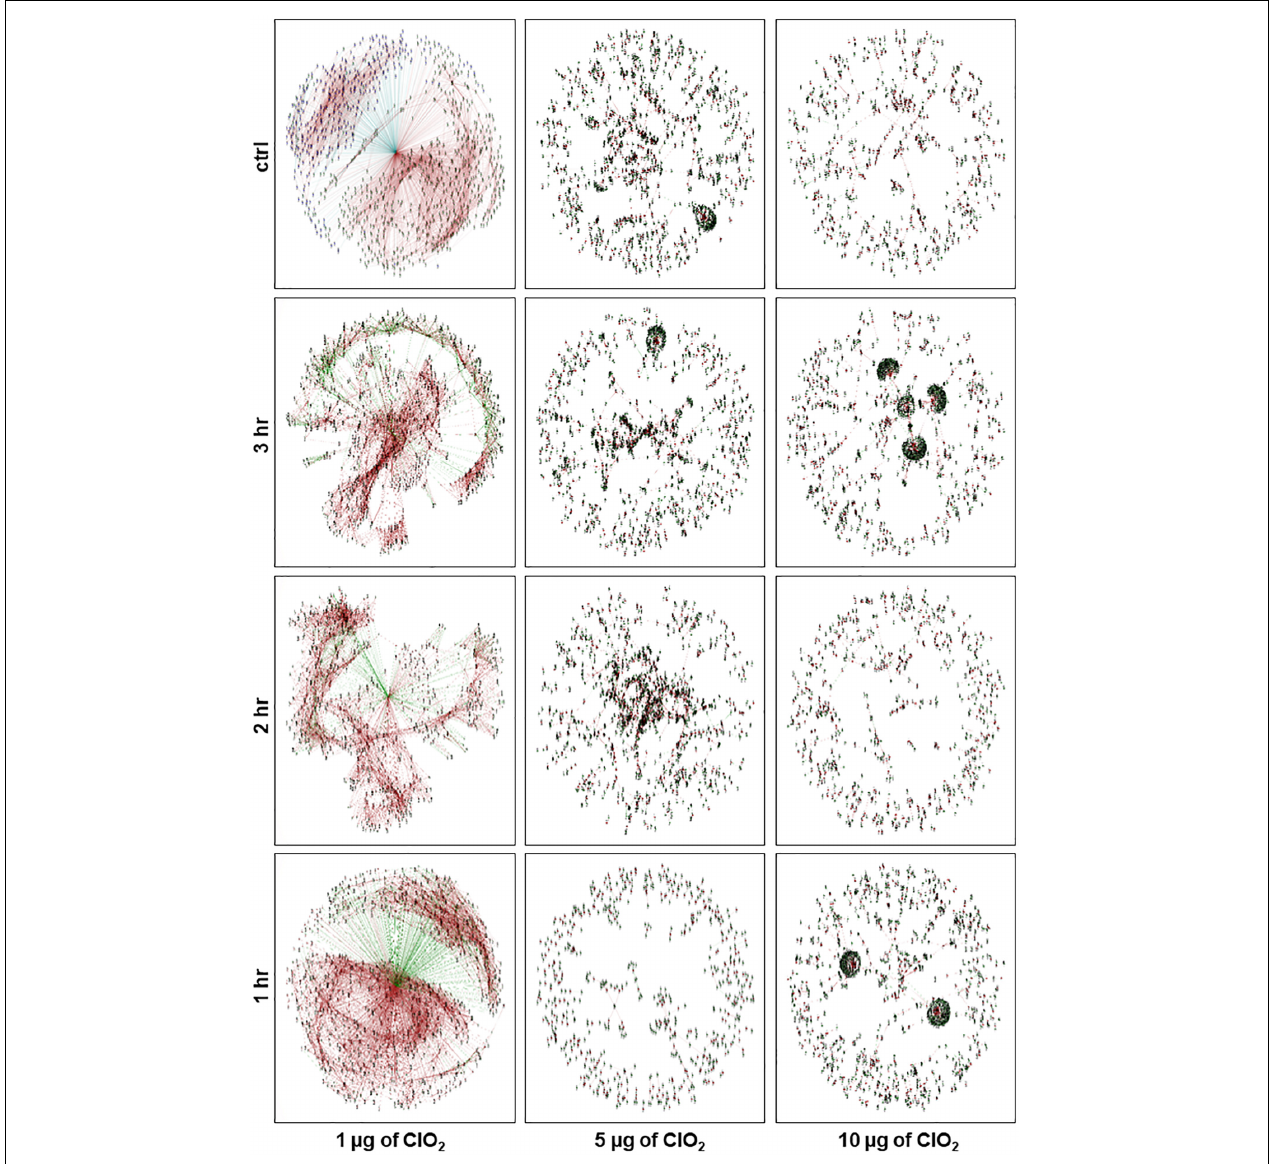
FIGURE 6 | Network view of the constructed E. coli gene co-expression networks at control condition and after 1 h, 2 h, and 3 h of exposure to ClO 2 . Each node represents a gene and each line denotes the gene expression correlation between the two nodes. Green node denotes upregulated genes, blue node denotes downregulated genes, brown line denotes positively correlated by Pearson Correlation Coefficient (PCC), and green line denotes negatively correlated by